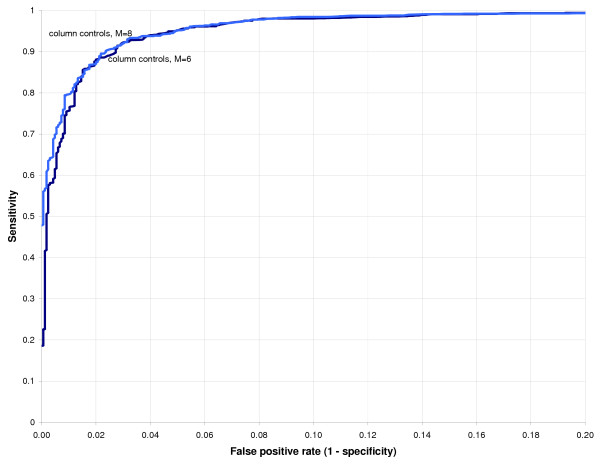
Higher M parameter improves quality of classification when using the z score method. ROC curves comparing effectiveness of the best control generation method for sequence pairs (i.e. columnwise shuffle of a global sequence alignment) at parameters M = 6 (dark blue) and M = 8 (light blue). Test set is same as for Figure 3. For all other control generation methods, increasing the M parameter value likewise increases the quality of classification (see Additional File 1 in "Additional Files" for supporting figure).